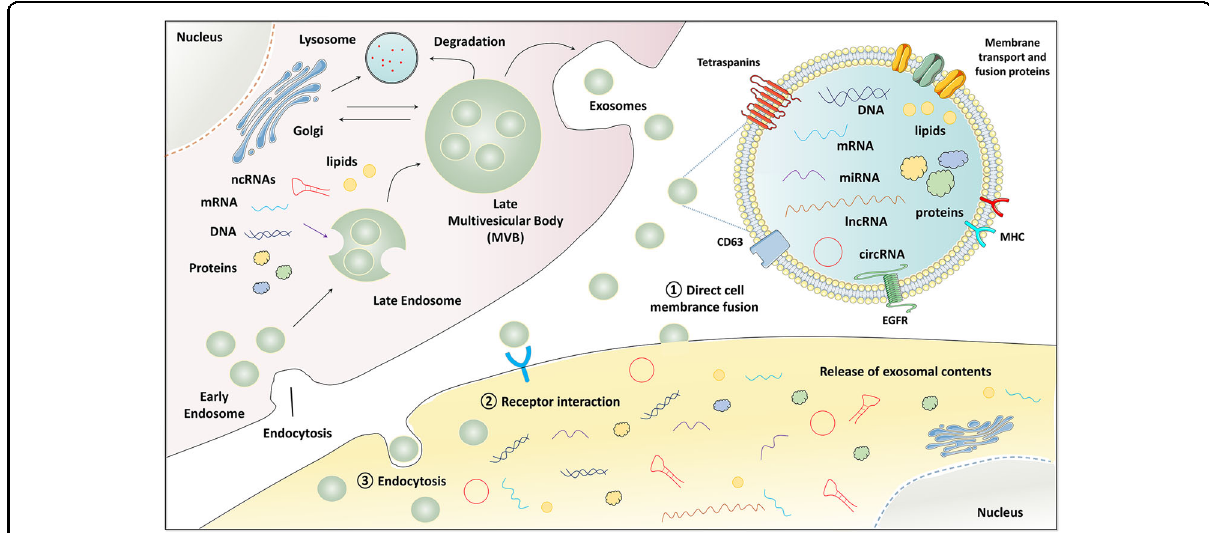
Fig. 1 The biogenesis, secretion, and uptake of tumor-derived exosomes. Firstly, the endocytosis results in the formation of early endosomes. Then, the endosomes and selected cargos including nucleic acids, proteins, and lipids are encapsulated into multivesicular bodies (MVBs). Finally, these MVBs fuse with the plasma membrane and release exosomes into extracellular place. The release of exosomal contents (proteins, mRNAs, miRNAs, lncRNAs, circRNAs, and DNAs) to the recipient cells via direct cell membrane fusion, receptor interaction, and endocytosis. noncoding RNA ncRNA, microRNA miRNA, long noncoding RNA lncRNA, circular RNA circRNA, major histocompatibility complex MHC, epidermal growth factor receptor EGFR, late multivesicular body